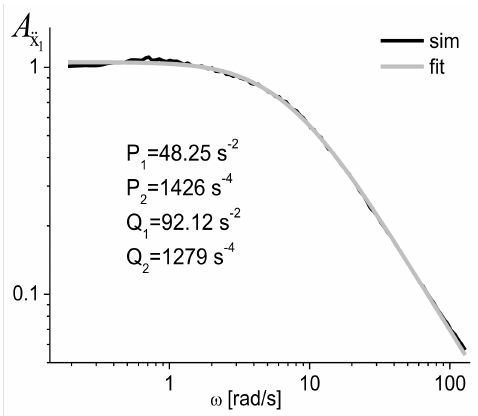
Figure 8. Simulated and fitted transmissibility factors for acceleration.